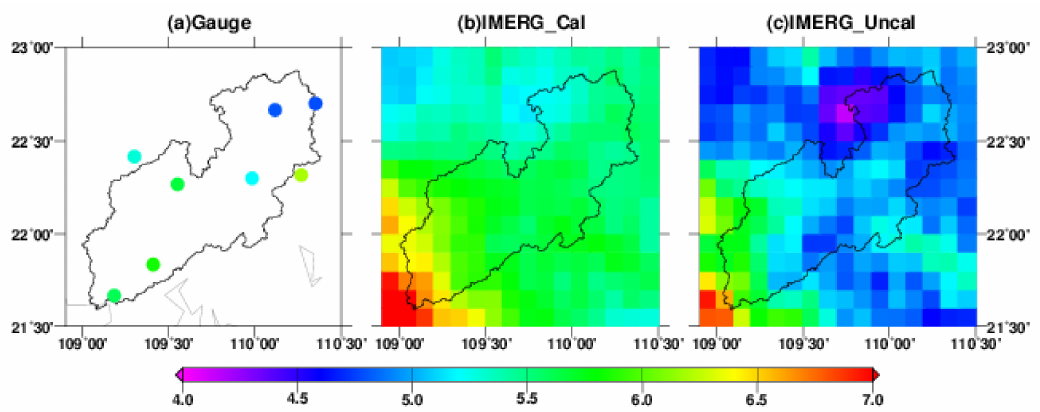
Figure 2. Spatial precipitation over the Nanliu River basin from the gauges and the IMERG, from April 2014 to December 2016 (mm/day).